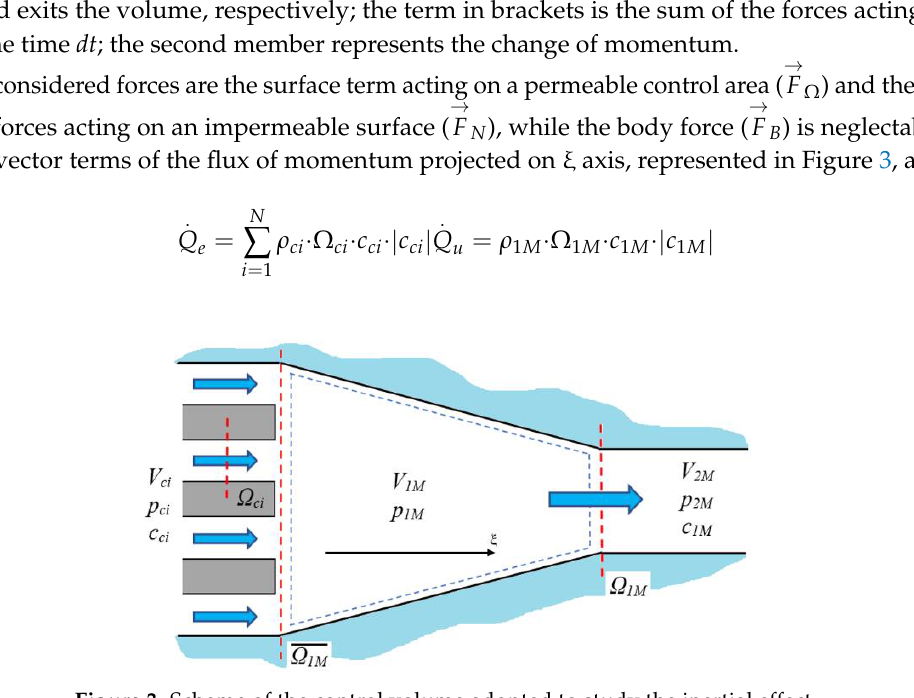
Figure 3. Scheme of the control volume adopted to study the inertial effect.